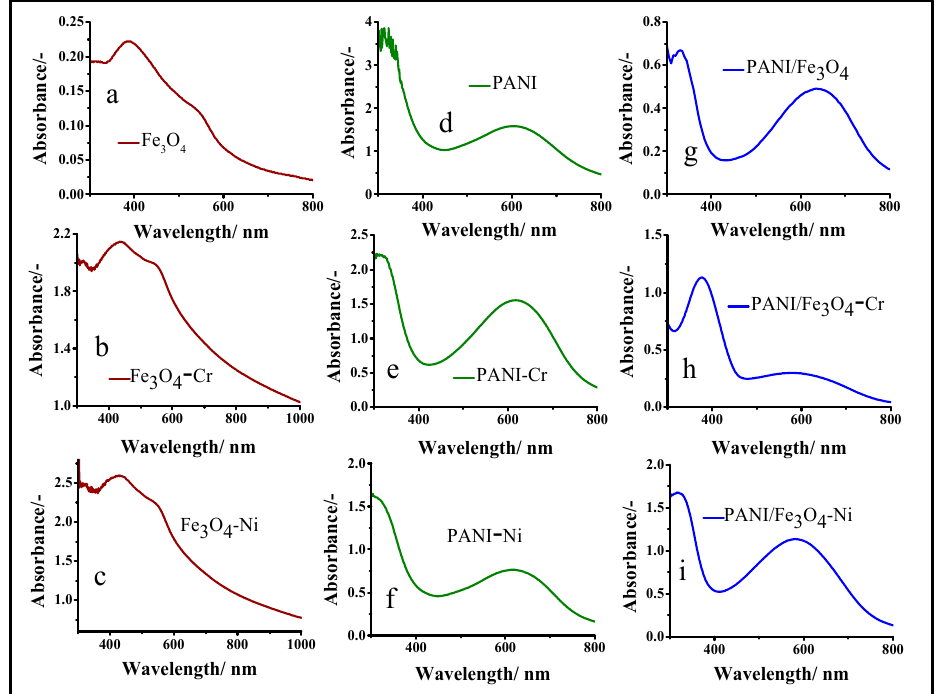
Figure 3. UV-visible spectra of Fe 3 O 4 , PANI, and PANI/Fe 3 O 4 ( a – c ) before adsorption, ( d – f ) after adsorption of Cr(VI), and ( g – i ) after adsorption of Ni(II).